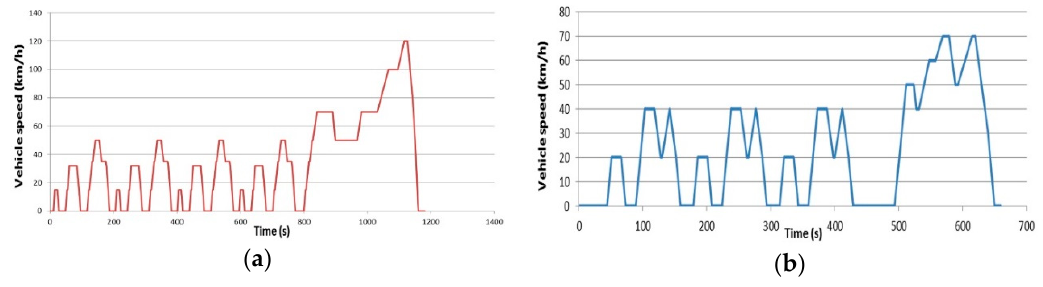
Figure 4. Driving cycles for EV simulation; ( a ) New European Driving Cycle (NEDC), ( b ) 10–15 mode cycle.